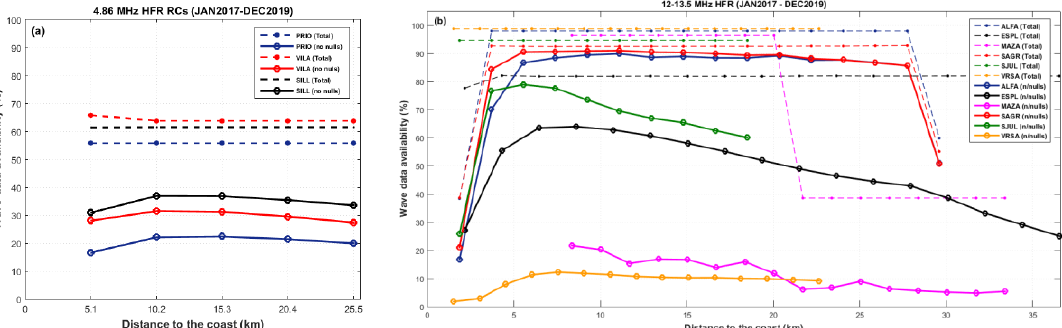
Figure 3. Overview of captured and useful HFR wave data per RC against distance from the coast (36-months period data sets). ( a ) 4.86 MHz HFR stations (Blue line: PRIO; Red line: VILA; Black line: SILL) and ( b ) 12–13.5 MHz HFR stations (black line: ESPL; blue line: ALFA; red line: SAGR; pink line: MAZA; green line: SJUL; orange line: VRSA). Dashed lines represent the total availability, and the solid lines the availability without radar nulls. Dots and circle markers represent each RC.